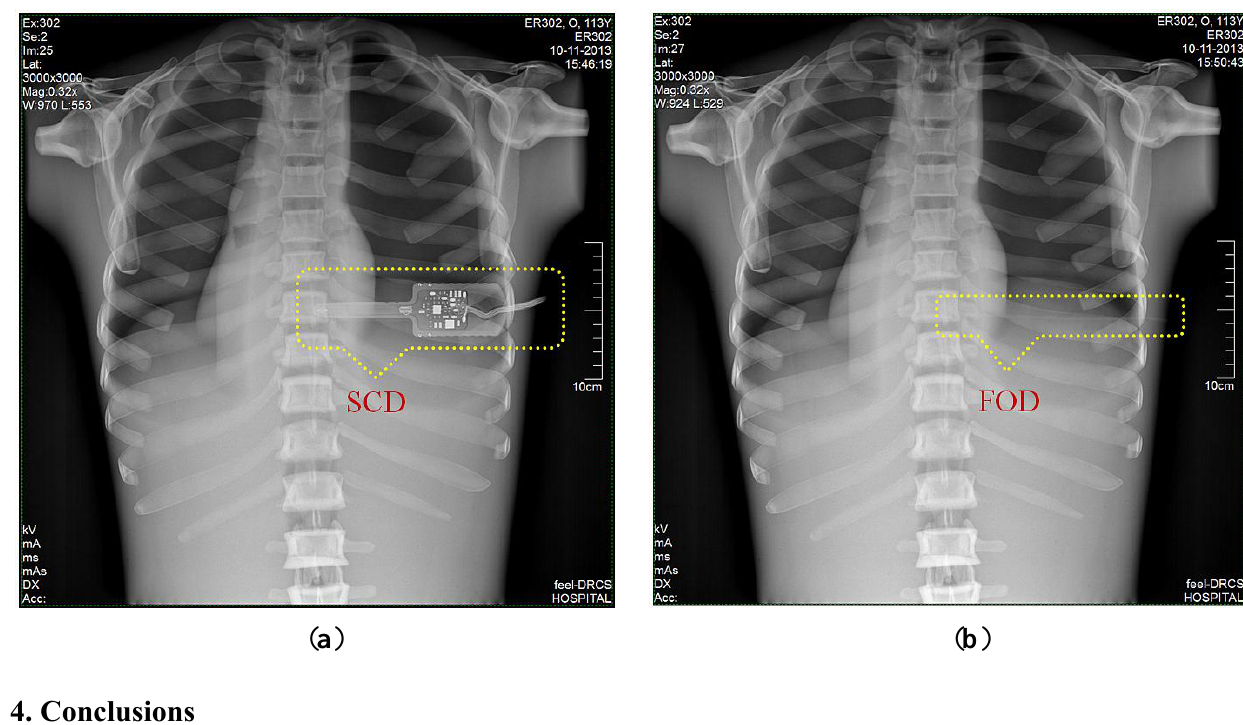
Figure 9. DR images of anthropomorphic thorax phantom with ( a ) a SCD and ( b ) a